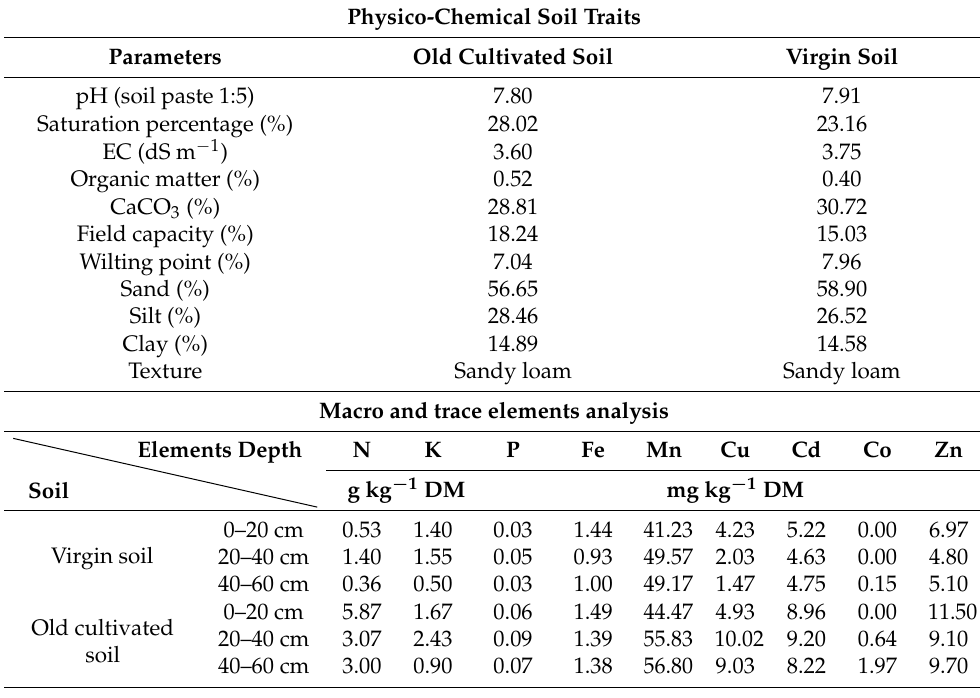
Table 1. Physico-chemical properties and elemental analysis of old cultivated and virgin soil before sowing. Physico-Chemical Soil Traits Parameters